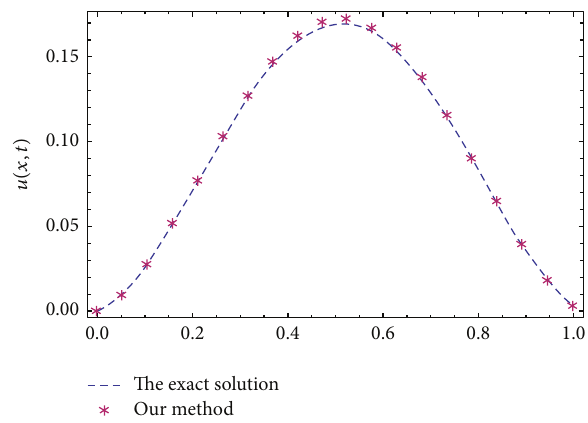
Figure 1: Exact solutions and numerical solutions with 𝜎 = 𝜌 = 1/1000 and ℎ = 𝜏 = 1/80 at 𝑇 = 1.0